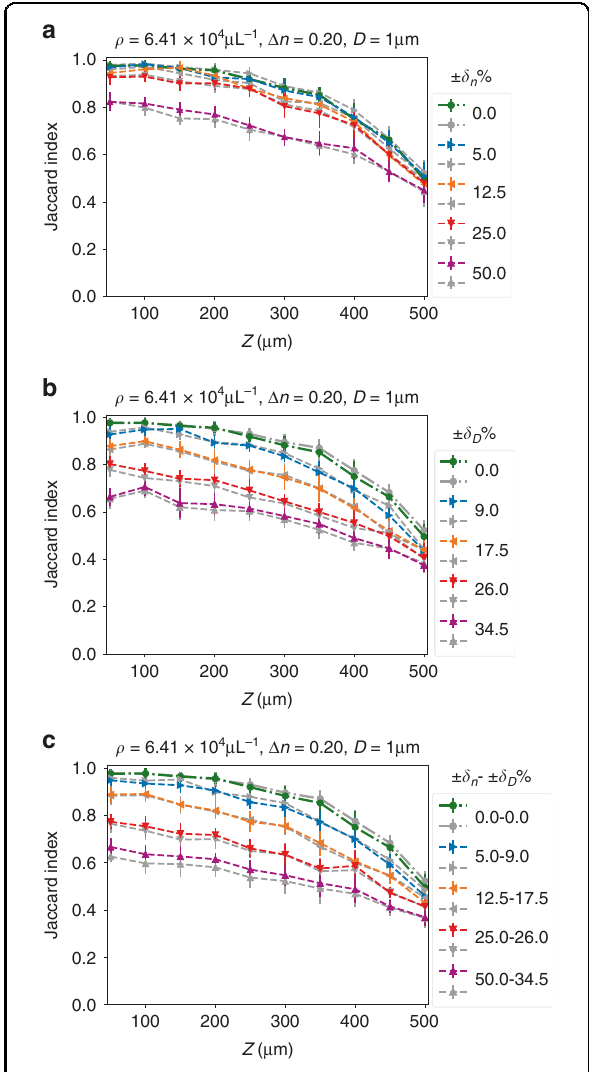
Fig. 5 Comparison of the generalization capability between the DSN and the 3× generalist. The testing volumes contain particles with a uniformly distributed random refractive index contrast; b uniformly distributed random particle size; and c uniformly distributed random refractive index contrast and particle size. The testing particle density ( ρ ), central refractive index ( Δ n ), and central particle size ( D ) are shown in the title in each plot. The variation ranges of the refractive indices and the particle sizes are marked by ± δ n % and ± δ D %, respectively. The green dash-dotted line is the baseline unseen case at ρ = 6.41×10 4 particles μ L − 1 , with a fi xed refractive index contrast Δ n = 0.20 and a fi xed particle size D = 1.0µm. The DSN results are shown in dashed lines in different colors for different cases; the corresponding 3× generalist results are shown in gray dashed lines with the matching markers. The DSN outperforms the 3× generalist as the scattering condition become more different from the baseline